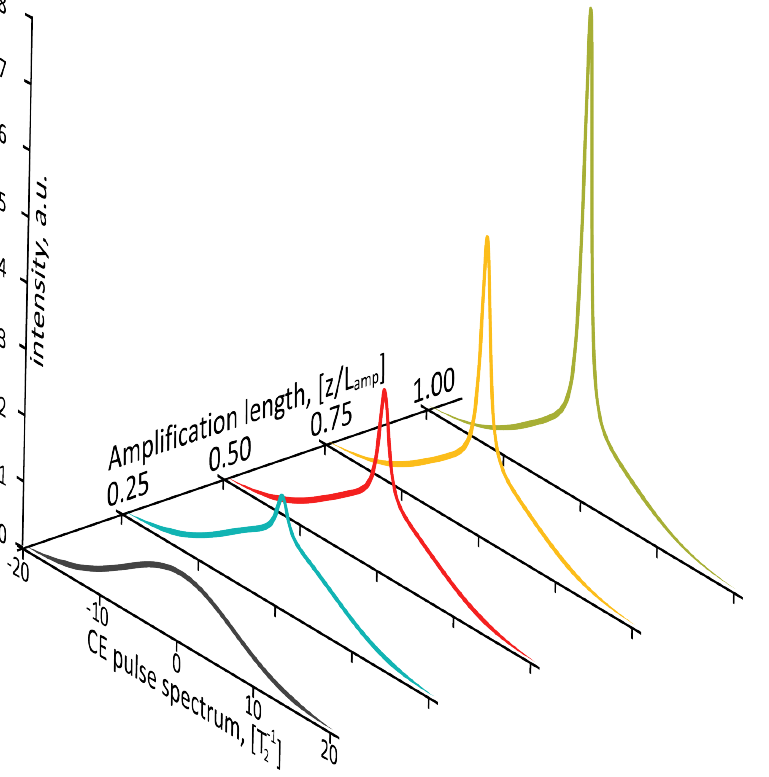
Figure 6. Spectrum narrowing of the IR cone emission pulse when it propagates in Xe excited by the under-threshold pump KrF laser pulse. Initial IR pulse spectrum is Gaussian with the width 1 ps, T 2 = 10 ps, the pump pulse area is constant and equals to the threshold value, τ =